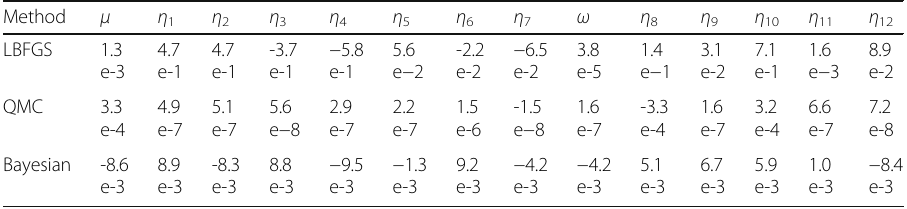
Table 4 The GARCH parameters for the ODR sector